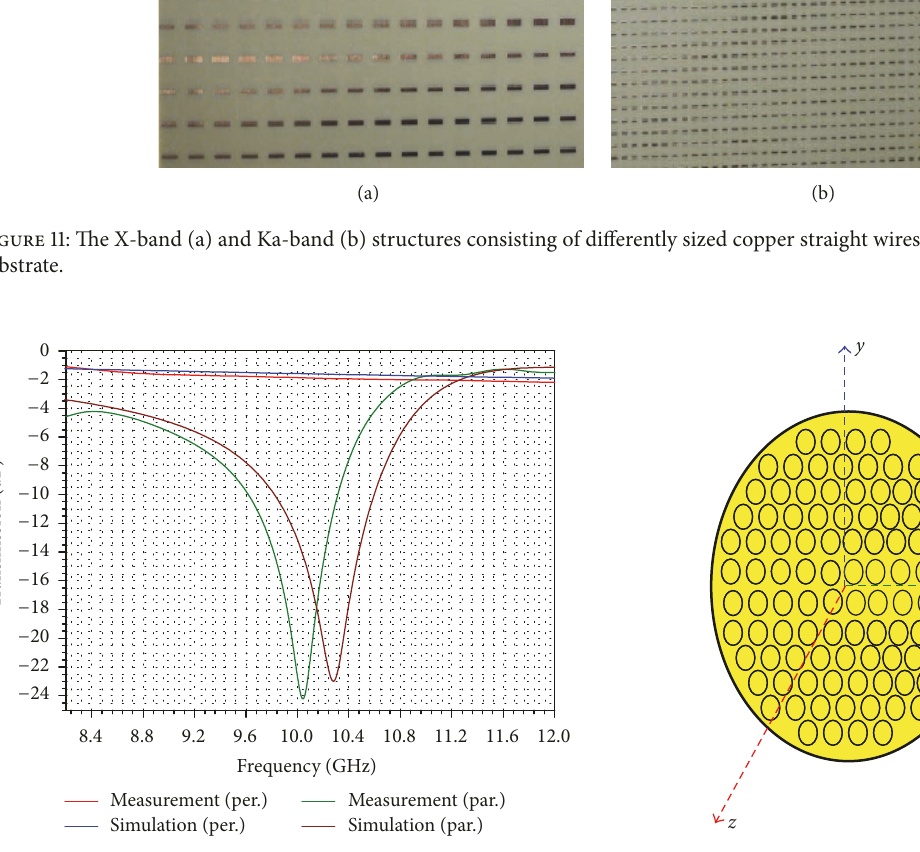
Figure 12: Measured and simulated (HFSS) transmission through the X-band structure.